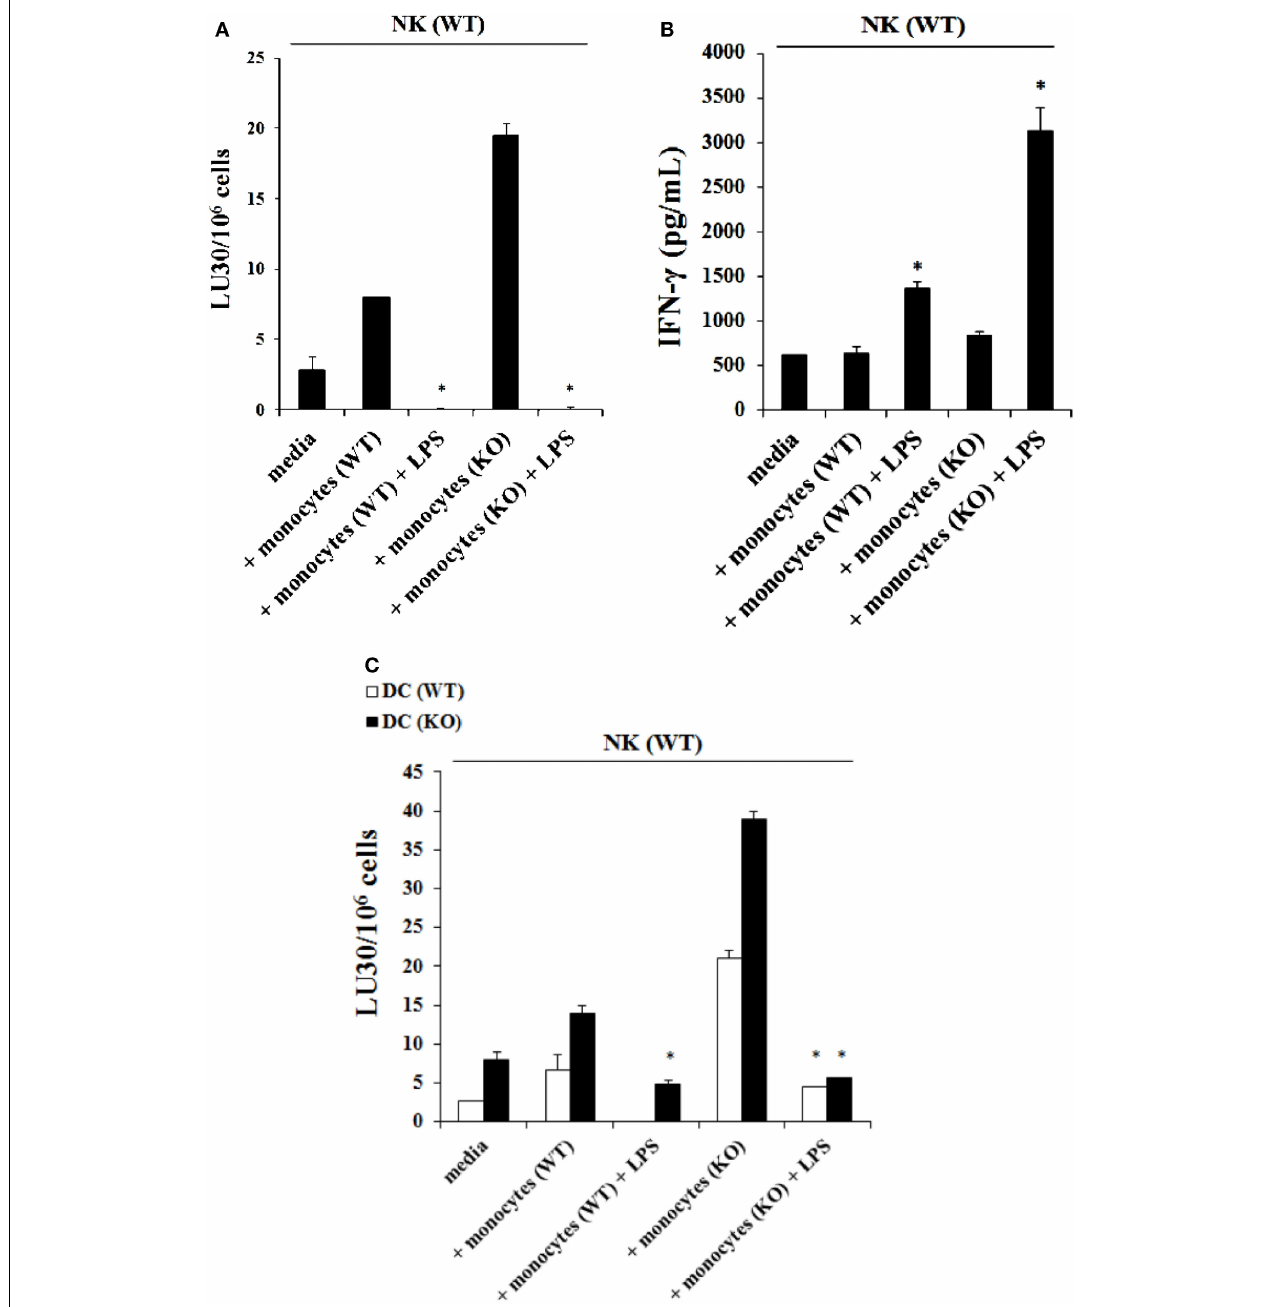
FIGURE 4 | The addition of LPS to NK cells cultured with monocytes induced split anergy in NK cells which resulted in significant inhibition of NK cell cytotoxicity but increased IFN- γ secretion . IL-2-treated (1 (cid:2) 10 4 U/million) NK cells obtained from wild type mice were cultured with monocytes from wild type mice or Cox-2 flox/flox ;LysM Cre/ + mice for 7days and then treated with or without LPS (20ng/mL) for an additional day. Afterward, NK cells were used as effector cells in a standard 4h 51 Chromium release assay against YAC-1 cells. The lytic units 30/10 6 cells were determined using inverse number of NK cells required to lyse 30% of the target cells (cid:2) 100. * P < 0.05 was obtained for differences in cytotoxicity between untreated and LPS-treated NK cells cultured with monocytes from control littermates or those from